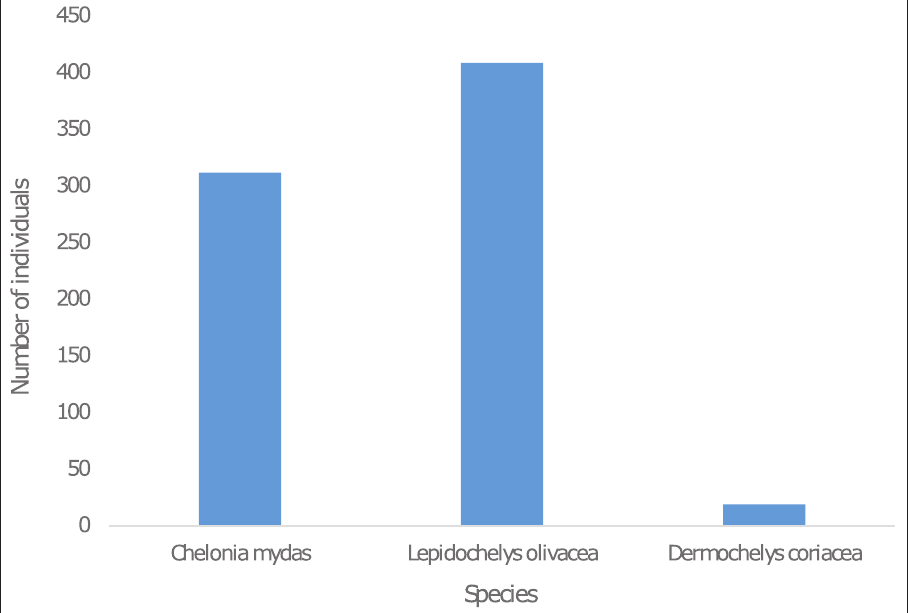
Figure 3. Distribution of marine turtle occurrences by species on the Togolese coast.